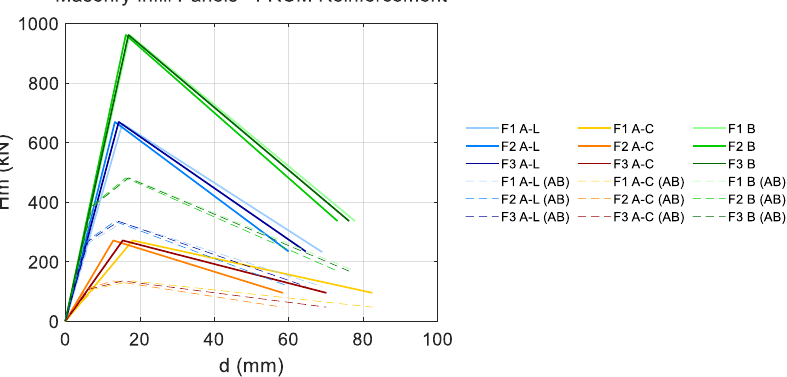
Figure 12. Original and strengthened masonry infill panels constitutive models.